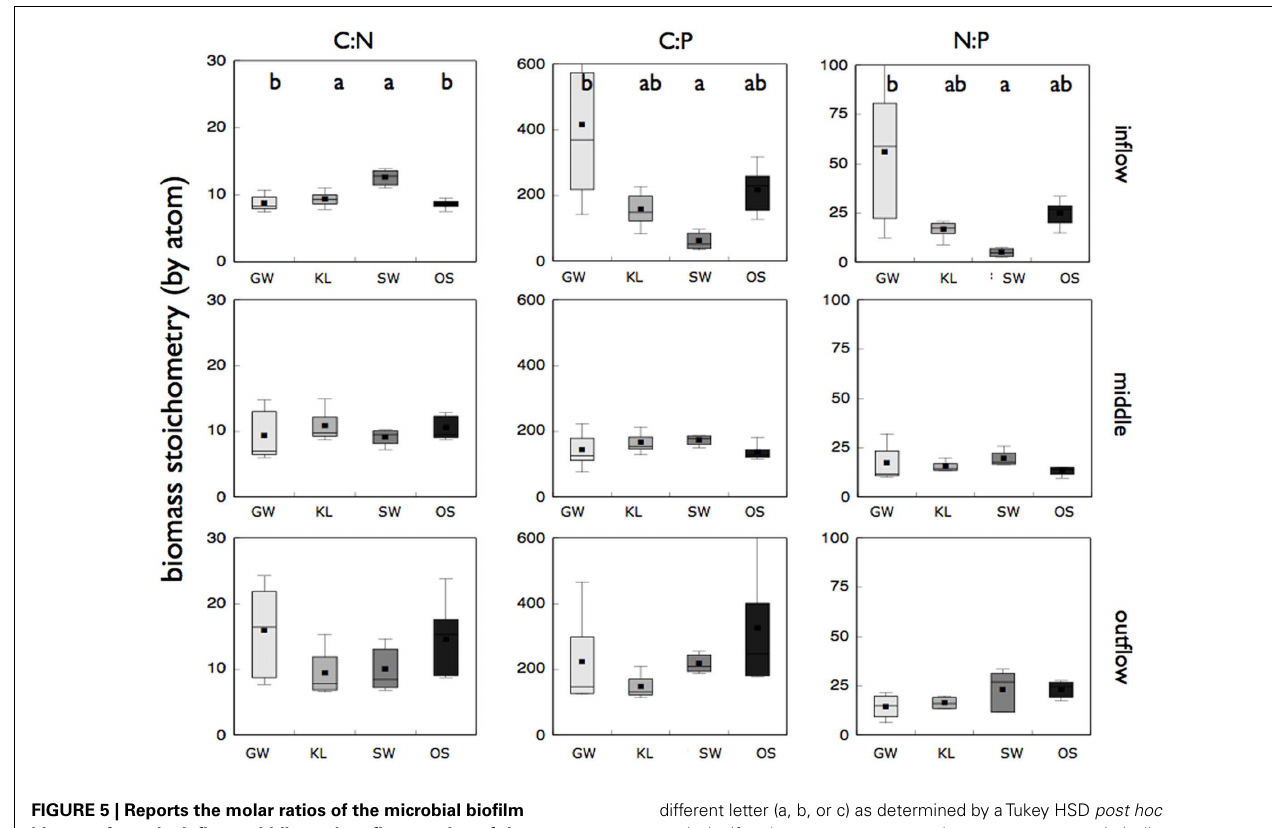
FIGURE 5 | Reports the molar ratios of the microbial biofilm biomass from the inflow, middle, and outflow section of the bioreactors for each treatment as labeled. Treatments that are significantly different ( p < 0.05) from one another are denoted with a